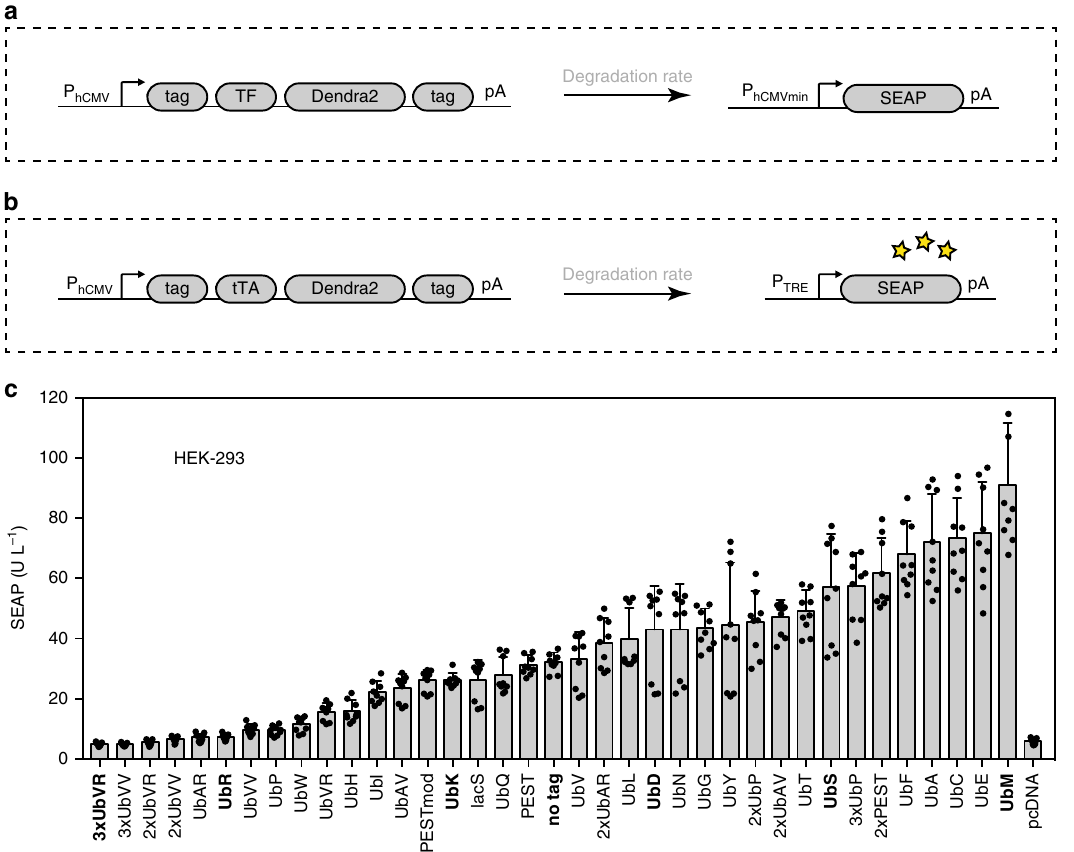
Fig. 1 Design and set-up of the protein tag library. a Schematic of the constructs forming the library. The core of the constructs consists of a transcription factor (TF) fused to the photoconvertible protein Dendra2. The protein modi fi cations (tag) affecting the degradation rate of the constructs are fused to TF- Dendra2 either at the N- or at the C- terminus. b To characterize the degron library, each degron was used to tag a tetracycline-dependent transactivator (tTA), which binds to its cognate Tet response element (TRE) located at the 5 ′ - end of a minimal promoter placed in front of the human secreted embryonic alkaline phosphatase (SEAP) reporter gene (P TRE - SEAP -pA). c Complete library of 36 protein modi fi cations. HEK-293 cells (3 × 10 4 ) were transfected with the different constructs (P hCMV -tag- tTA - Dendra2 -pA, containing the tetracycline-dependent transactivator tTA) and the reporter gene (P TRE - SEAP -pA). SEAP levels were pro fi led after 24 hours (h) in the culture supernatant. The degrons marked in bold are the six ubiquitin (Ub) fusion constructs bearing the tags 3xUbVR, UbR, UbK, UbD, UbS, and UbM, which were selected as providing representative degradation patterns. The data represent the mean ± SD ( n = 3 independent experiments). Source data for this fi gure is available in the Source data fi